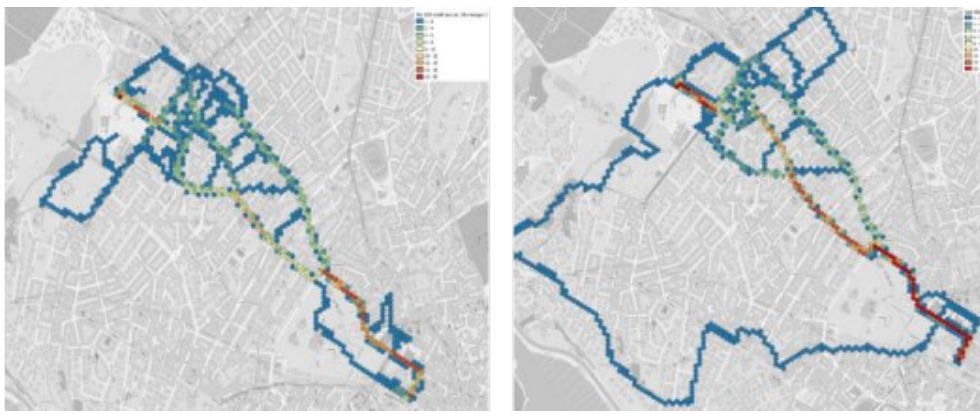
Figure 5 Route choice, pre-intervention (N = 20) and post-intervention (N=28)